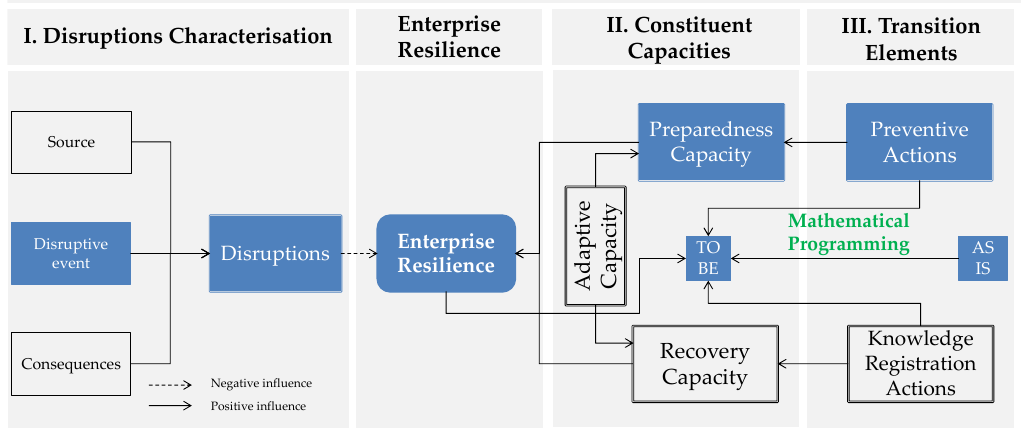
Figure 1. Enterprise resilience conceptual reference framework (based on [12]).